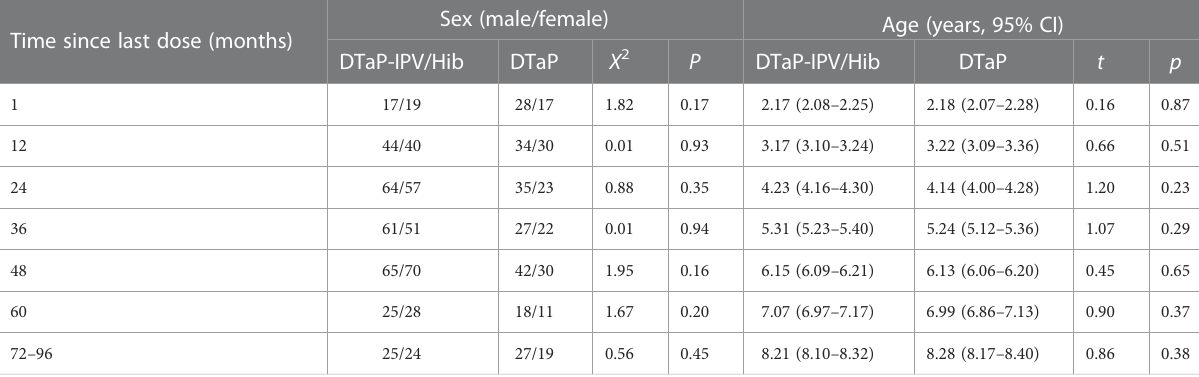
TABLE 2 Comparison of basic characteristics between the two study groups.